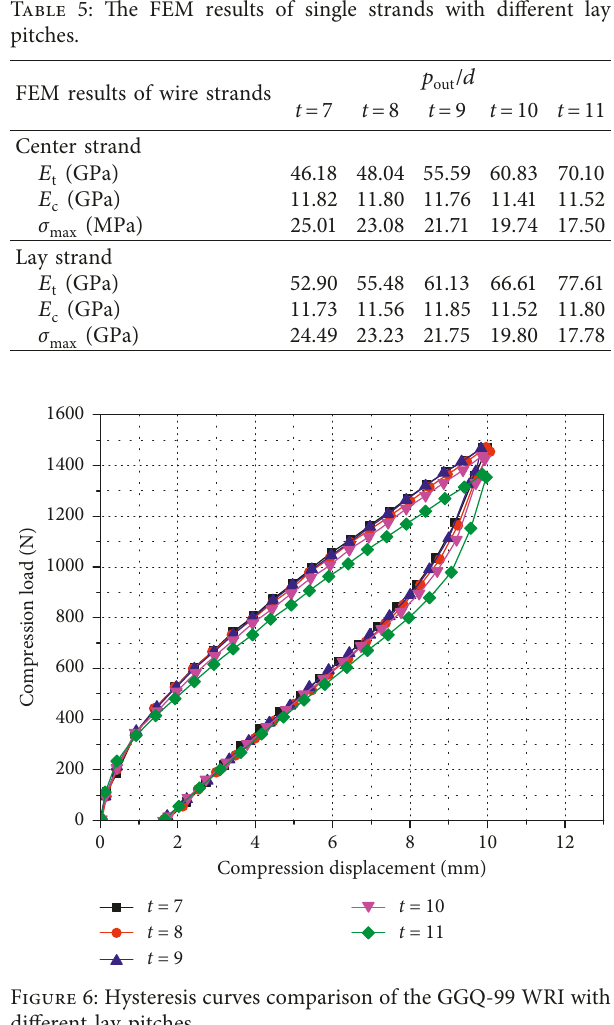
Figure 6: Hysteresis curves comparison of the GGQ-99 WRI with different lay